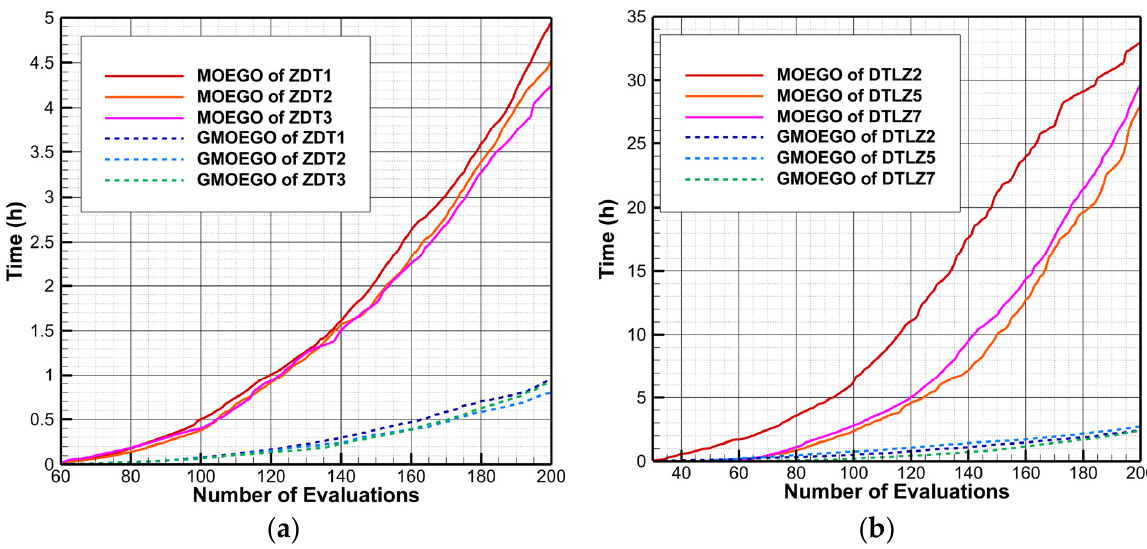
Figure 8. Wall-clock time history comparisons: ( a ) ZDT series functions; ( b ) DTLZ series